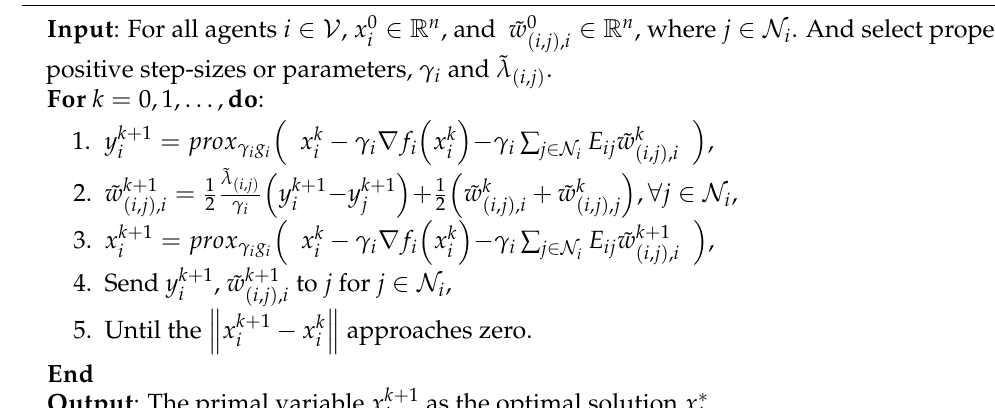
Algorithm 1 Distributed algorithm based on proximal